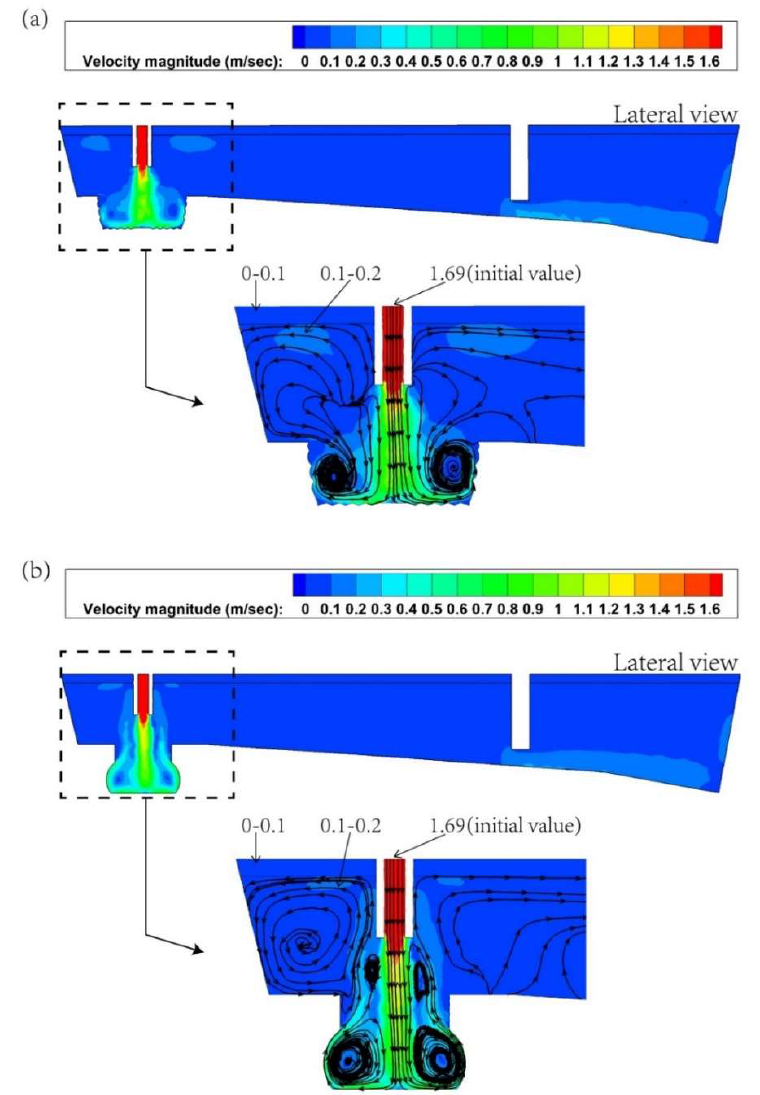
Figure 6. Flow field and velocity field of ( a ) case 1 and ( b ) case 2 at 850 s.